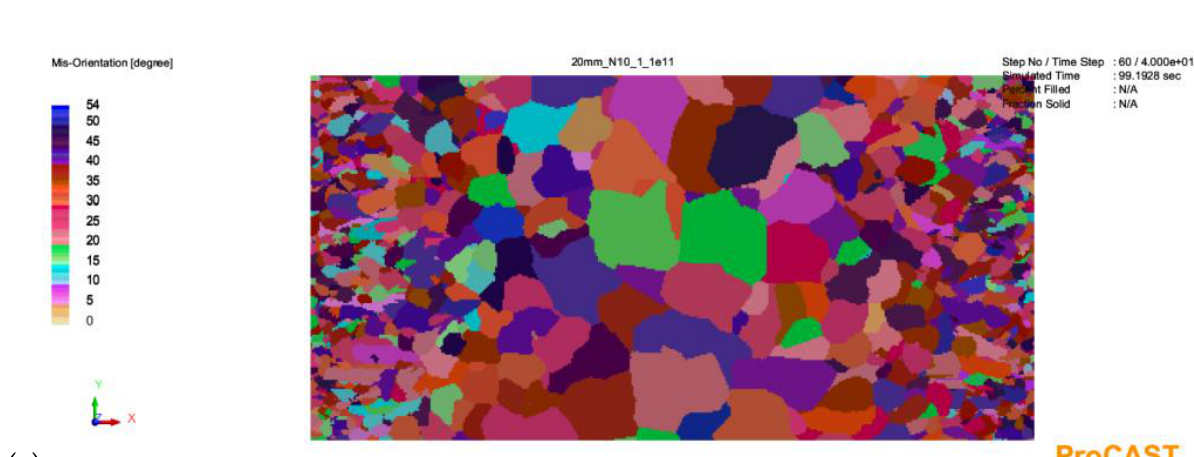
Figure 3. Simulation results for a casting wall thickness of 20 mm with a given number of austenite nucleation sites in the amount of: ( a )—10 9 ; ( b )—10 10 ; ( c )—10 11 .